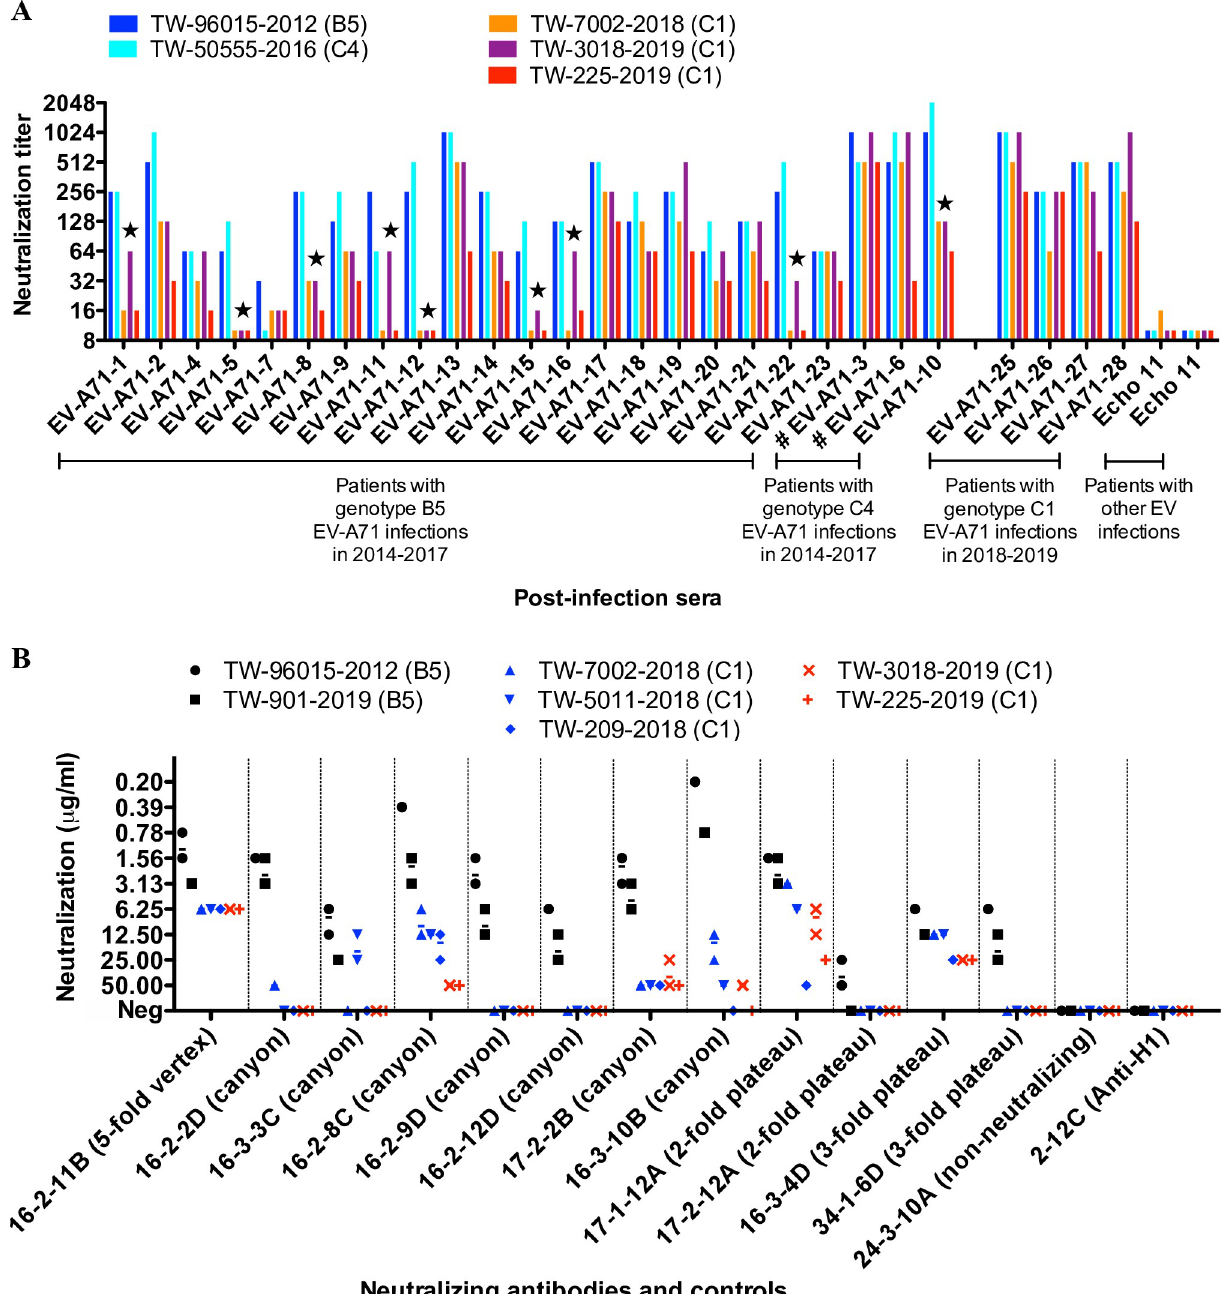
Fig 2. Neutralizing activities of human antibodies with the 2018–2019 genotype C1 EV-A71. ( A ) Neutralizing titers of polyclonal convalescent sera to EV-A71. A total of 23 sera were collected from hospitalized children with genotype B5 and C4 EV-A71 infection, 2014–2017 (refer to S3 Table). Sera from genotype C1 EV-A71- and echovirus 11-infected children were included as controls. Post-genotype C1 EV-A71 infection sera EV-A71-25, -26, -27, and -28 were obtained from subject 19, 20, 21, and 4, respectively (refer to S1 Table). Two post-genotype C4 EV-A71 infection sera (EV-A71-3 and -6) were obtained after intravenous immunoglobulin administration and marked with a hash sign. Each serum was assayed in triplicate for each virus with equivalent results. The serum that had an 8-fold decline in titers against the 2018–2019 genotype C1 EV-A71 compared to titers against the B5 and C4 virus is marked with a star. ( B ) Neutralizing activities of human monoclonal antibodies to EV-A71. Twelve neutralizing monoclonal antibodies that recognize the 5-fold vertex, canyon, 2-fold plateau, and 3-fold plateau epitopes on the viral capsid were tested. An EV-A71 capsid-targeting non- neutralizing antibody 24-3-10A and an influenza H1-targeting antibody 2-12C were included as controls. Each symbol represents an independent measurement. Some measurements overlap. The geometric mean concentration of neutralization is shown as a middle bar. In the neutralization assay, the failure of antibody up to 100 μ g/ml to prevent the cytopathic effect was determined as no virus neutralizing activity. Each antibody was assayed in